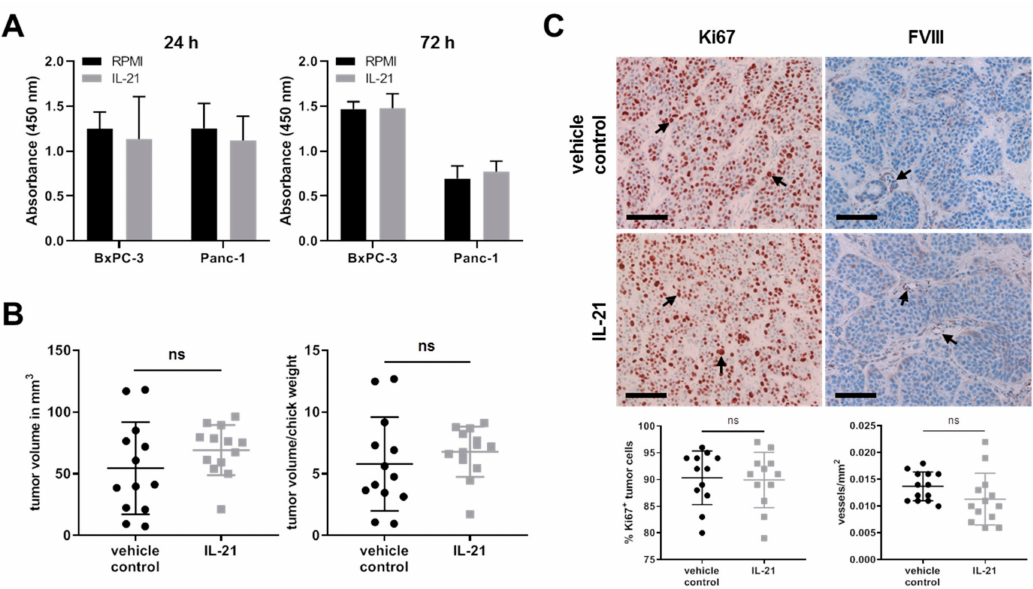
Figure 8. IL-21 treatment has no profound e ff ect on tumor cell proliferation. ( A ) Proliferation of BxPC-3 and Panc-1 was measured by a BrdU incorporation method at the indicated time points. Data from four independent experiments are shown. ( B ) Quantification of tumor volume and the ratio of tumor volume to chick weight. Unpaired t -test. ( C ) Comparison and quantification of Ki67 (nuclei: brown) and FVIII (tubular structure: brown) expression of vehicle control and IL-21-treated (150 ng / mL) xenograft tumors. Arrows indicate positive cells. Black bar: 100 µ m. Unpaired t